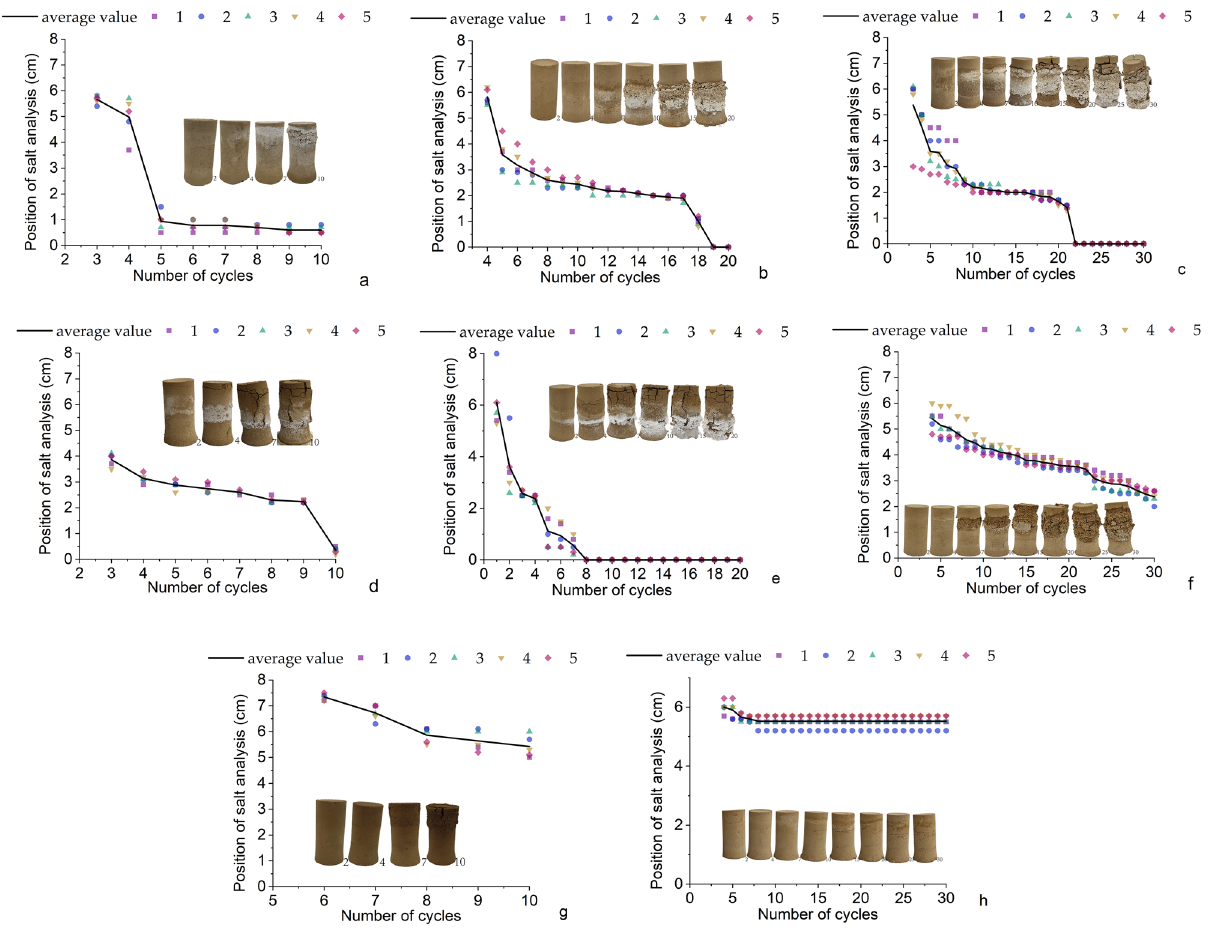
Figure 3. Change of mass and salt position of each soil column: ( a ) Experimental group 1; ( b ) Experimental group 2; ( c ) Experimental group 3; ( d ) Experimental group 4; ( e ) Experimental group 5; ( f ) Experimental group 6; ( g ) Experimental group 7; ( h ) Experimental group